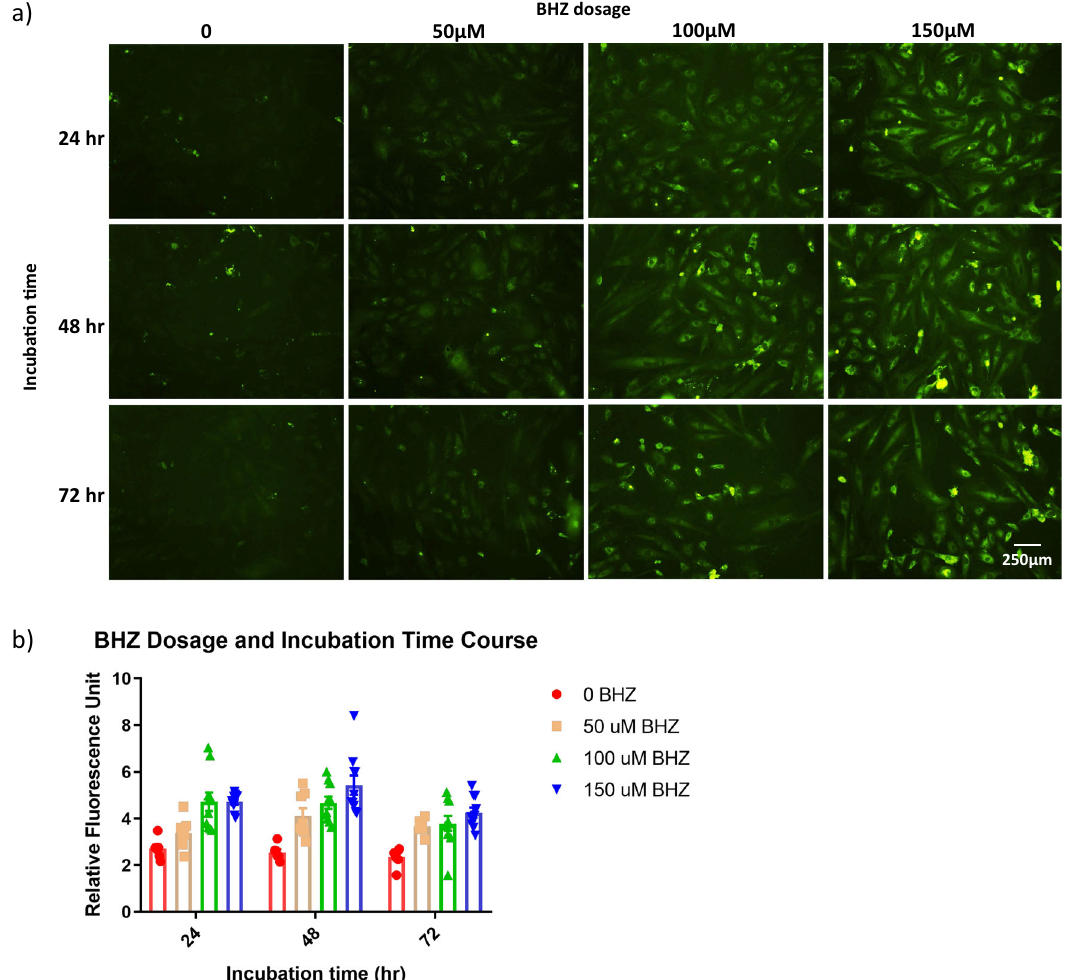
Fig. 3 Optimization of in situ LOXs activity assay parameters. a A7r5 cells overexpressing LOXL2 were seeded on coverslips and incubated with different concentrations of biotin-hydrazide (BHZ; 0, 50, 100, or 150 µ M) for 24, 48, or 72 h. After being fi xed and stained for immuno fl uorescence with DTAF- streptavidin, cells were imaged with confocal microscopy in fi ve independent coverslip locations per condition. (Scale bar = 250 µ m). b LOXs activity signal from each image was converted to grayscale and analyzed for mean gray value. ( n =